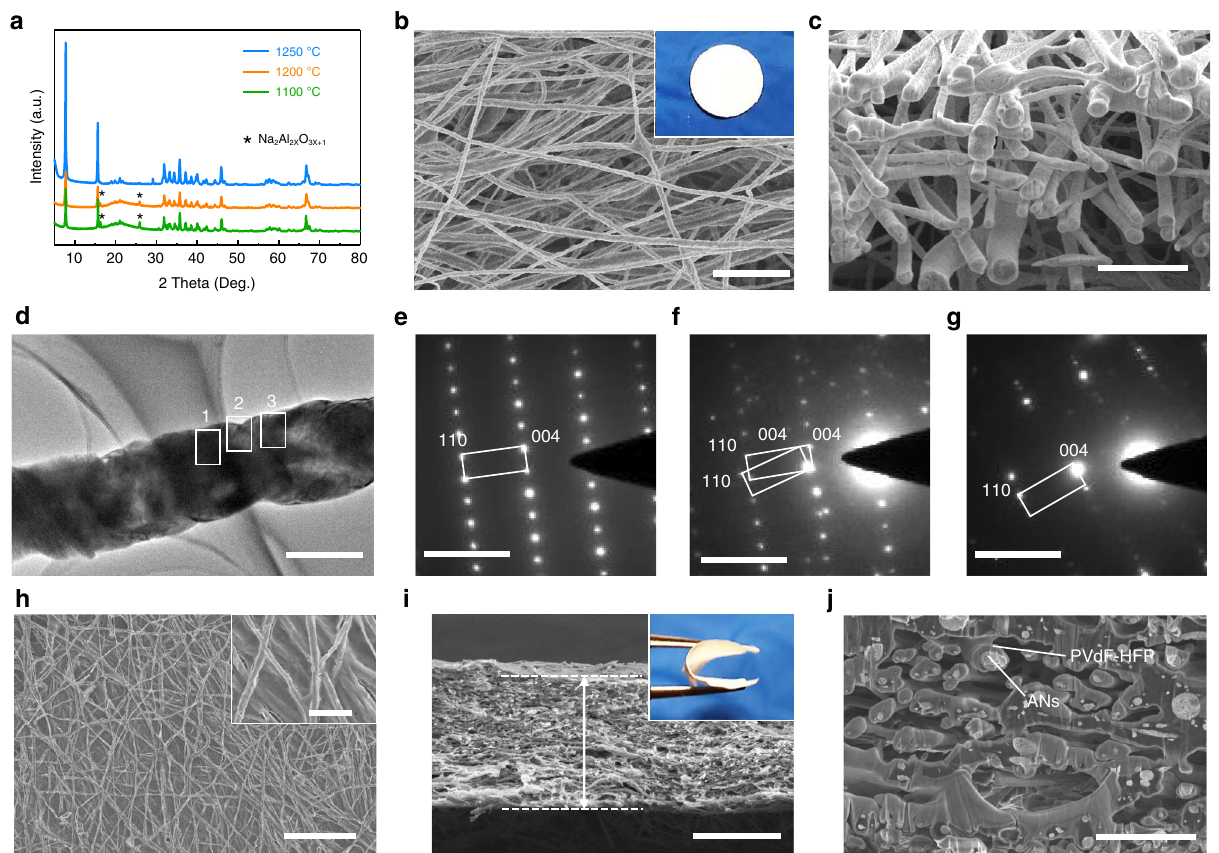
Fig. 2 Morphology and structural characterization of ANs and ANs – PVdF – HFP membranes. a XRD patterns of ANs prepared at different temperatures. b Surface and ( c ) cross-sectional SEM image of the ANs membrane. d TEM image of a single AN. e , f , g SAED patterns of areas 1, 2, and 3 in ( d ). h Surface and ( i , j ) cross-sectional SEM images of ANs – PVdF – HFP membranes. The inset in ( i ) is the digital image of the ANs – PVdF – HFP membrane. Scale